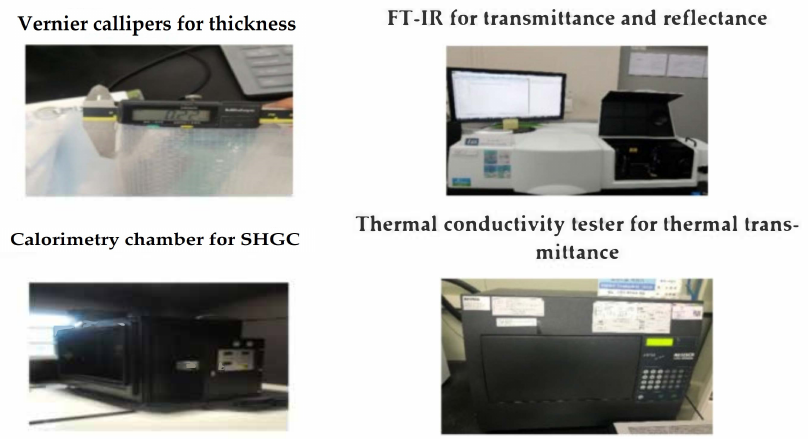
Figure 4. Test equipment for each test item.